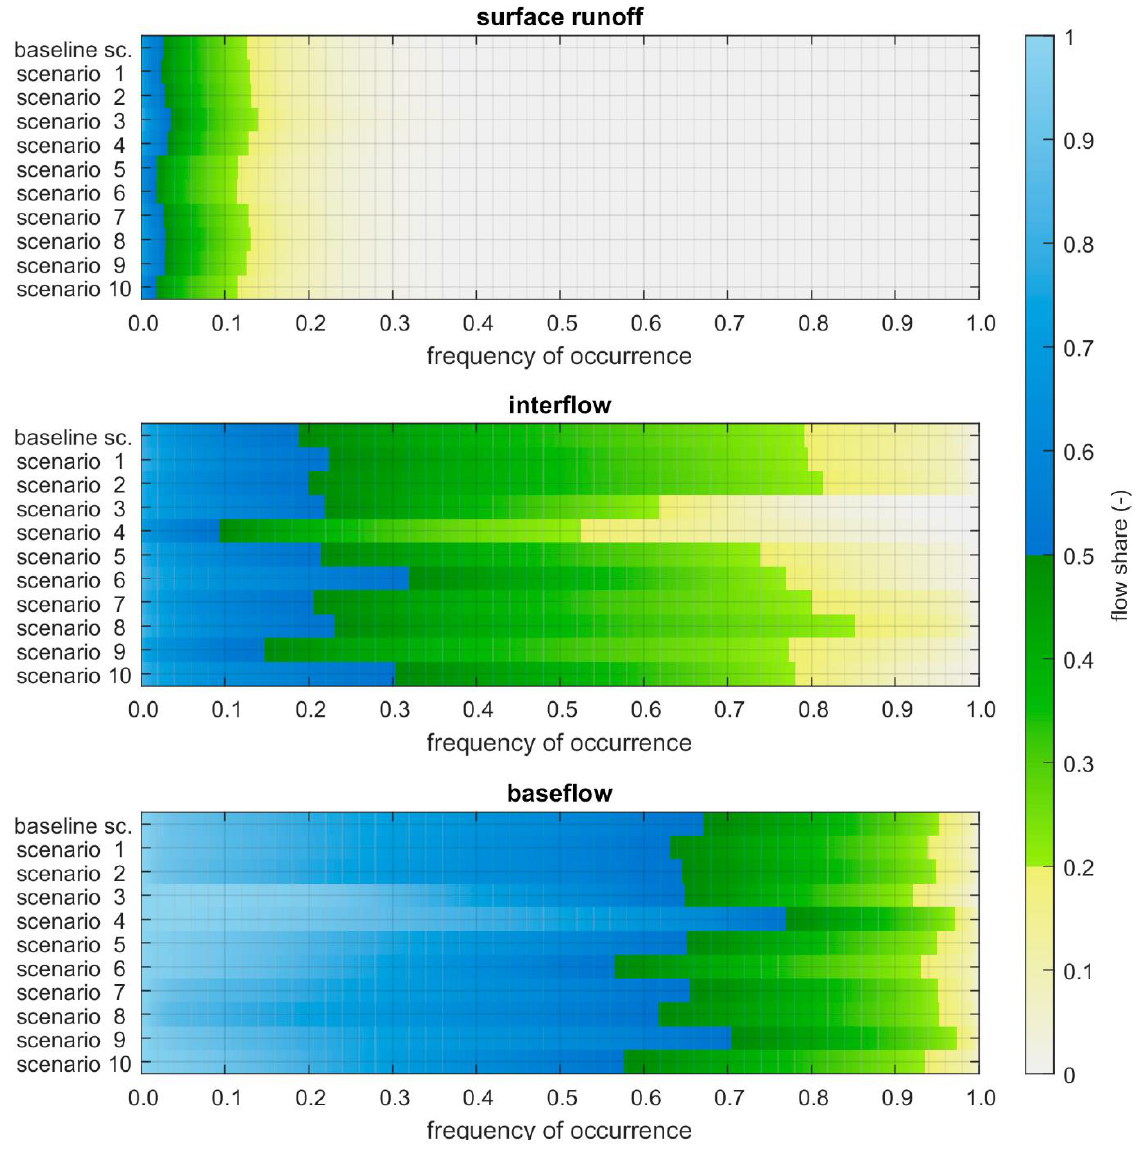
Figure 5. Frequency of occurrence of flow shares for all runoff components (scenario description: Table 3). In order to compare the spatial patterns of the evapotranspiration and runoff com- ponents simulated by 10 scenarios to the baseline scenario, we analyzed the Pearson cor- relation coefficient α and percentage of histogram overlap γ, considering the spatial mean of direct runoff, interflow, baseflow, and actual evapotranspiration (ETa) (Table 8). Table 8. Spatial correlation (correl) and histogram overlap (histo) of the 10 scenarios compared to the baseline scenario, for spatial mean of direct runoff, Interflow, baseflow, and ETa Scenario